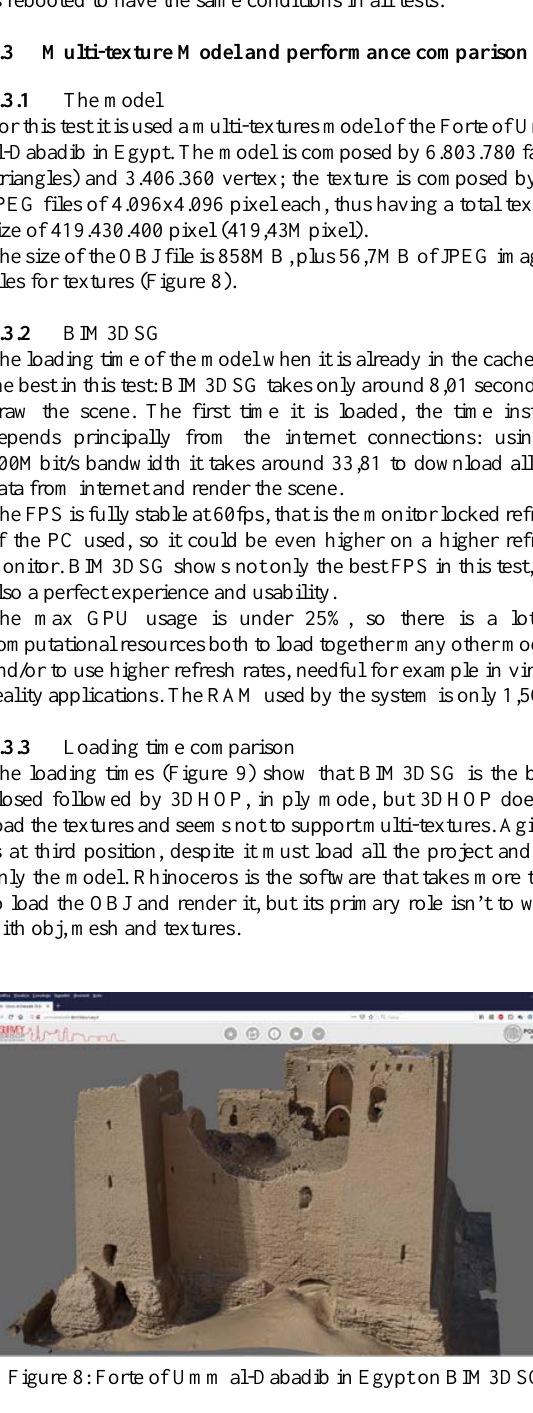
fluidity; when the FPS drops down 30 FPS every people detects poor fluidity, stuttering, motion sickness and so on;